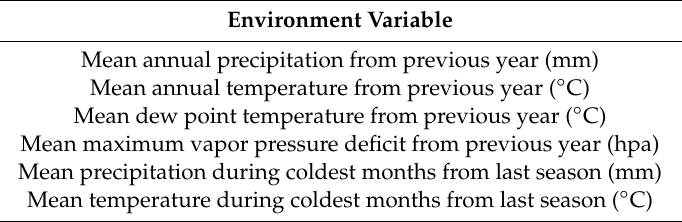
Table 2. Environmental variables used in the MaxEnt models.